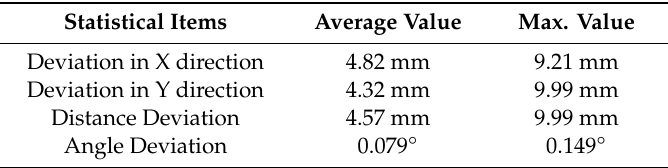
Table 5. Total trial data summary for the repeated tests.